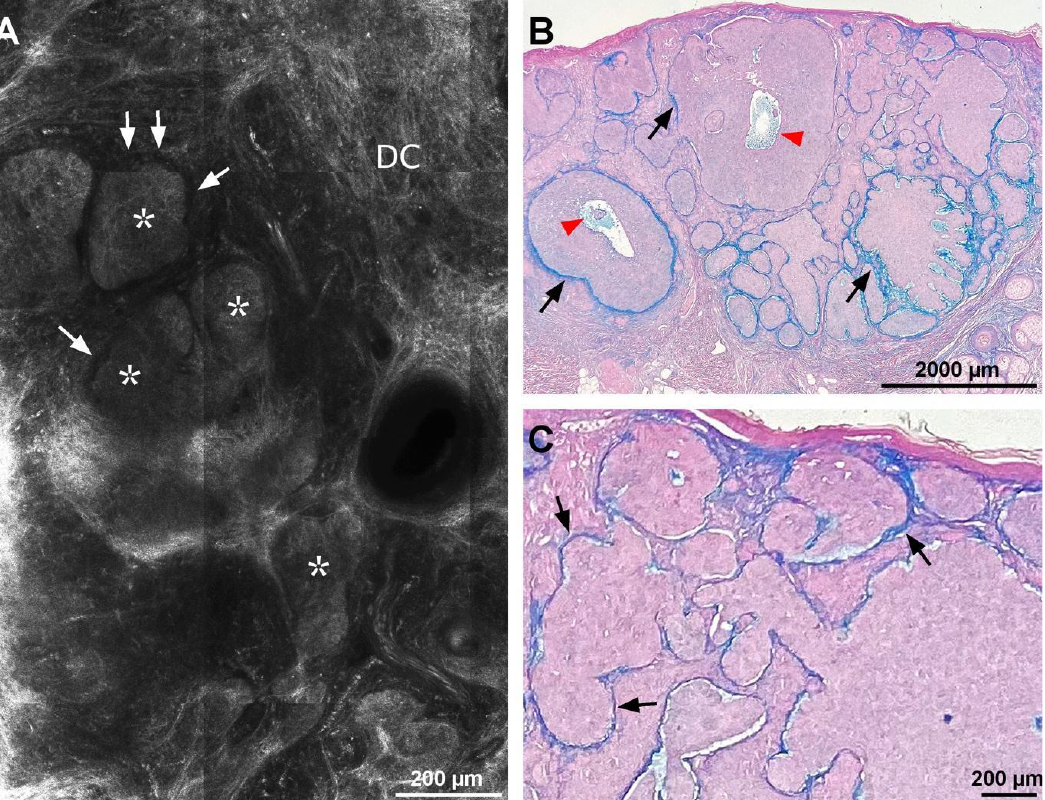
Figure 1. Correlation of reflectance confocal microscopy (RCM) image and colloidal iron-stained histological aspect of a nodular basal cell carcinoma (BCC). ( A ) RCM mosaic showing basaloid tumor nodules (white asterisks) displaying peripheral palisading, separated from dermal collagen (DC) by hyporeflective peritumoral spaces also known as clefts (white arrows). ( B ) Photomicrograph showing blue mucin deposits around, in between (black arrows), and inside (red arrowheads) single BCC tumor nodules (colloidal iron stain). ( C ) Histology corresponding to panel ( A ) showing BCC tumor islands separated from the adjacent dermis by mucin staining blue (black arrows) (colloidal iron stain). RCM and histopathology images belong to the same case. Table 1. Peritumoral hyporeflective cleft width and hyper-reflective globule sizes obtained by three random measurements in histological samples and RCM images of the lesions.